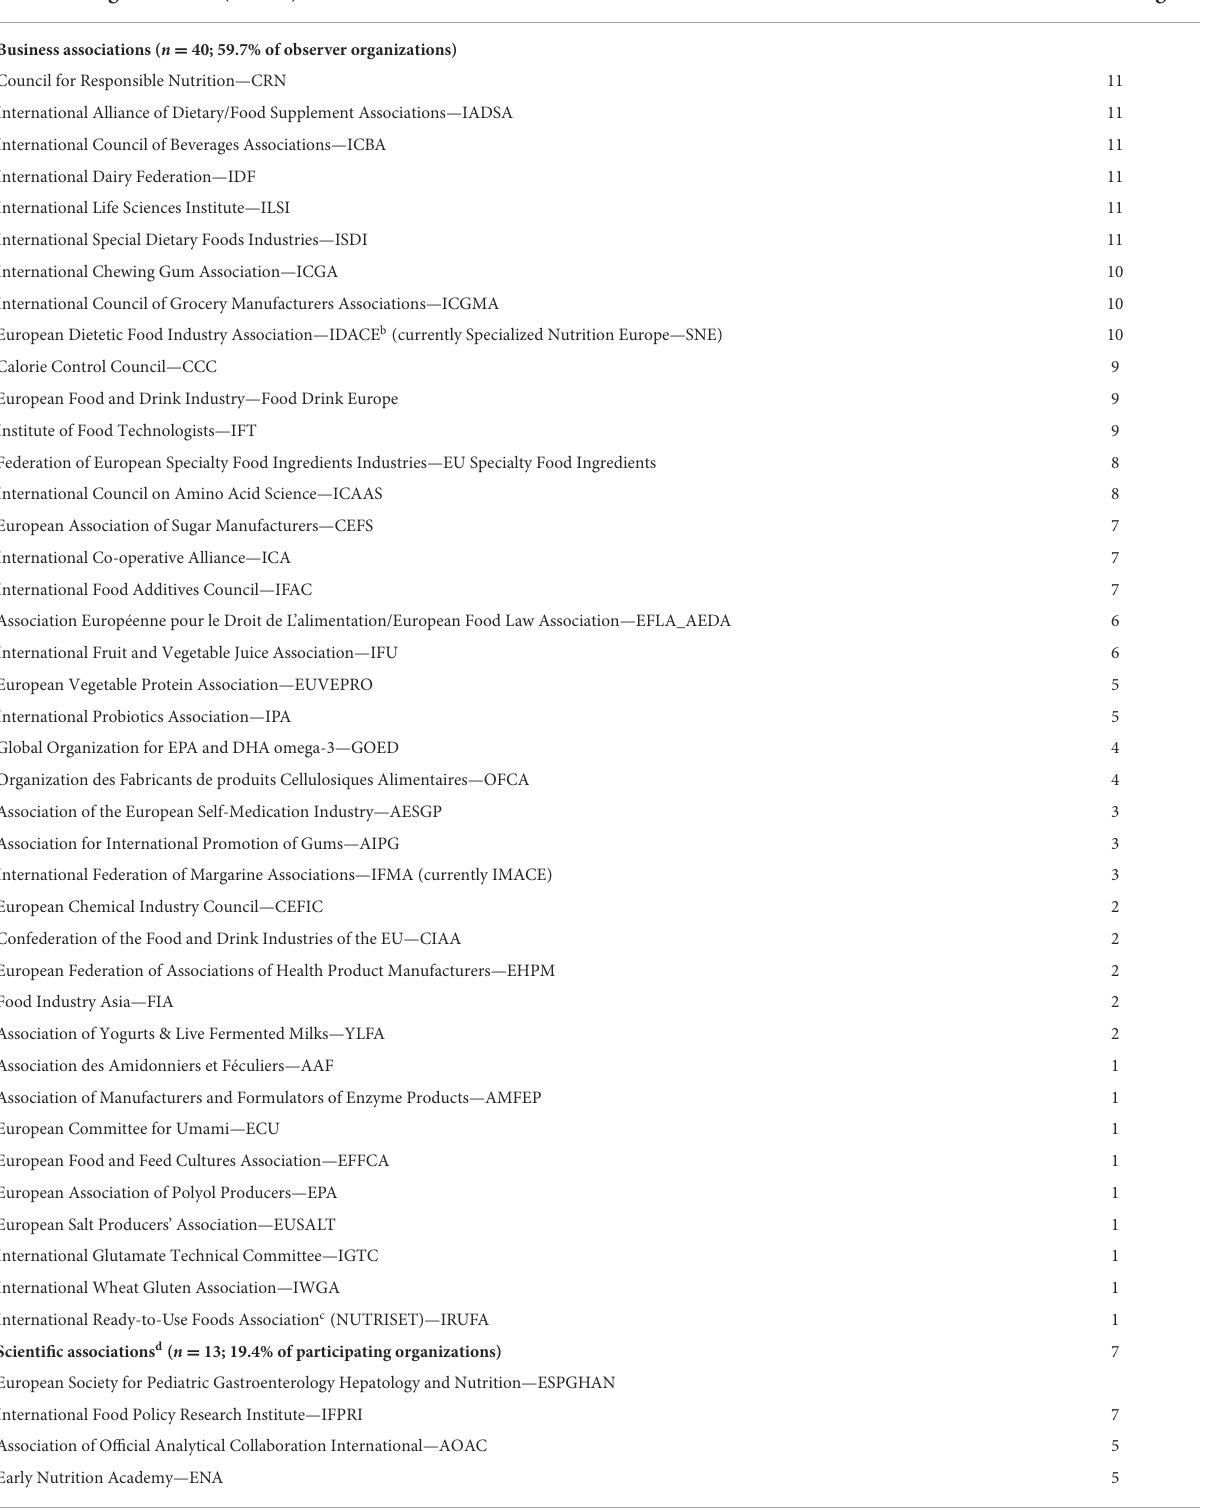
TABLE 6 Observer organizations attending CCNFSDU a